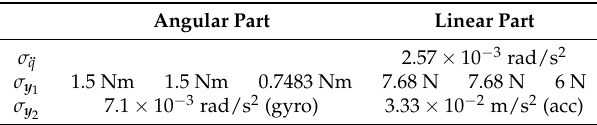
Table 1. Standard deviation σ from sensors’ datasheets.